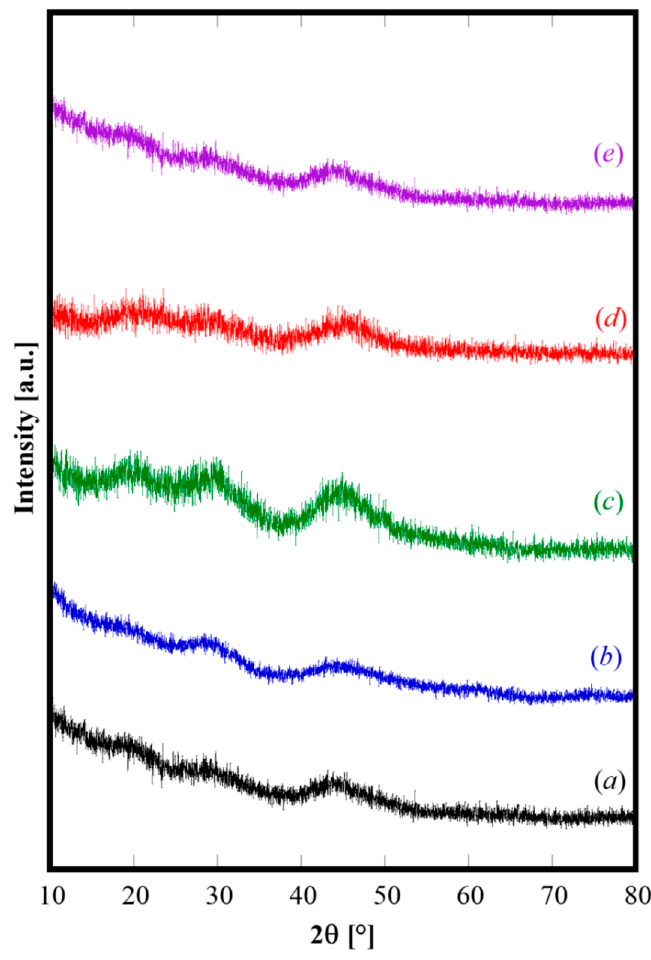
Figure 1. X-ray powder diffraction (XRD) patterns of samples C ( a ), GDC20 ( b ), SDC20 ( c ), GPrDC20 ( d ), and SCaDC20 ( e ).